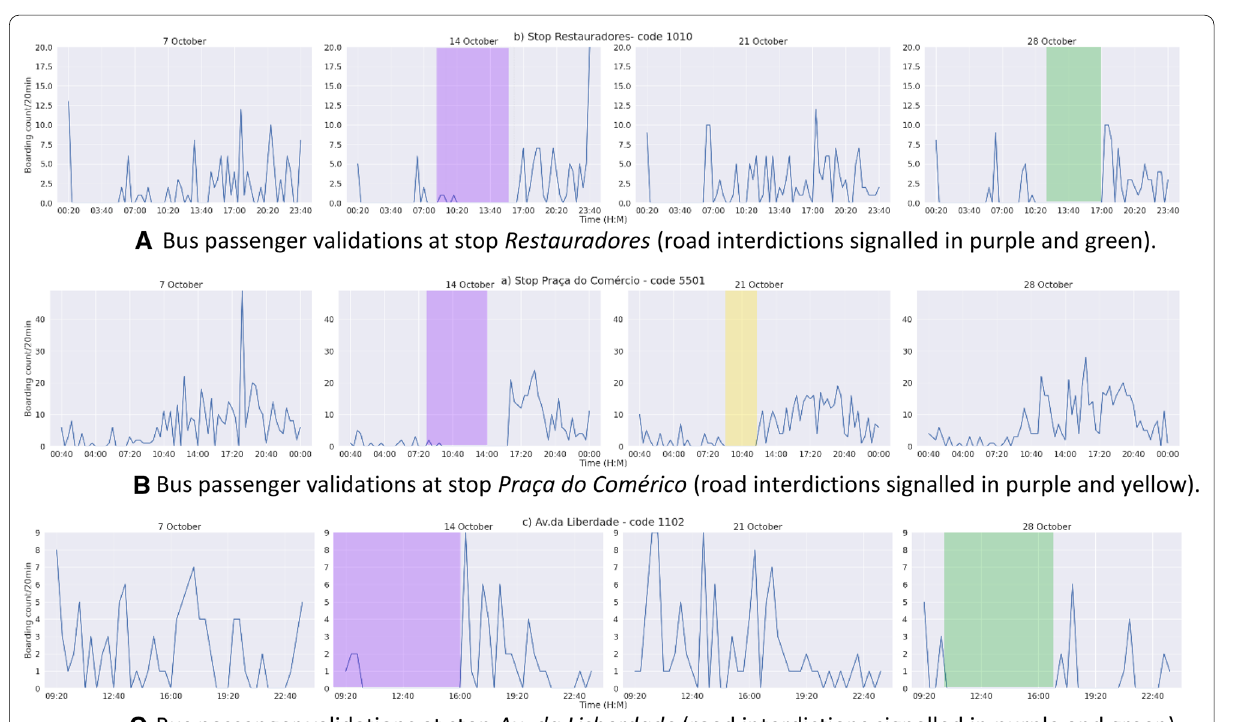
Fig. 9 a Bus passenger validations at stop Restauradores (road interdictions signalled in purple and green). b Bus passenger validations at stop Praça do Comérico (road interdictions signalled in purple and yellow). c Bus passenger validations at stop Av. da Liberdade (road interdictions signalled in purple and green)